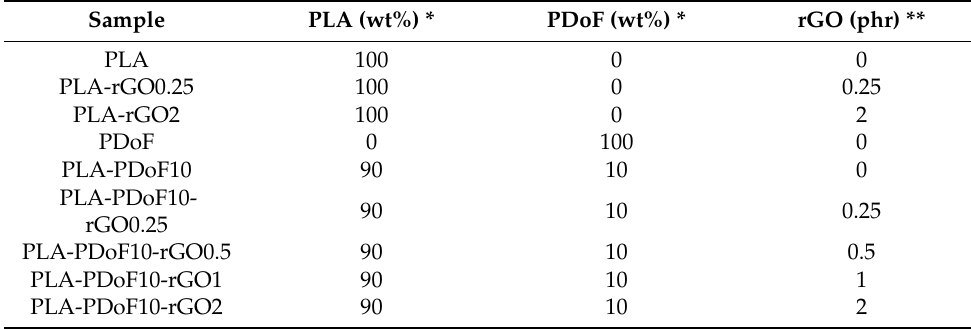
Table 4. List of prepared samples with nominal weight